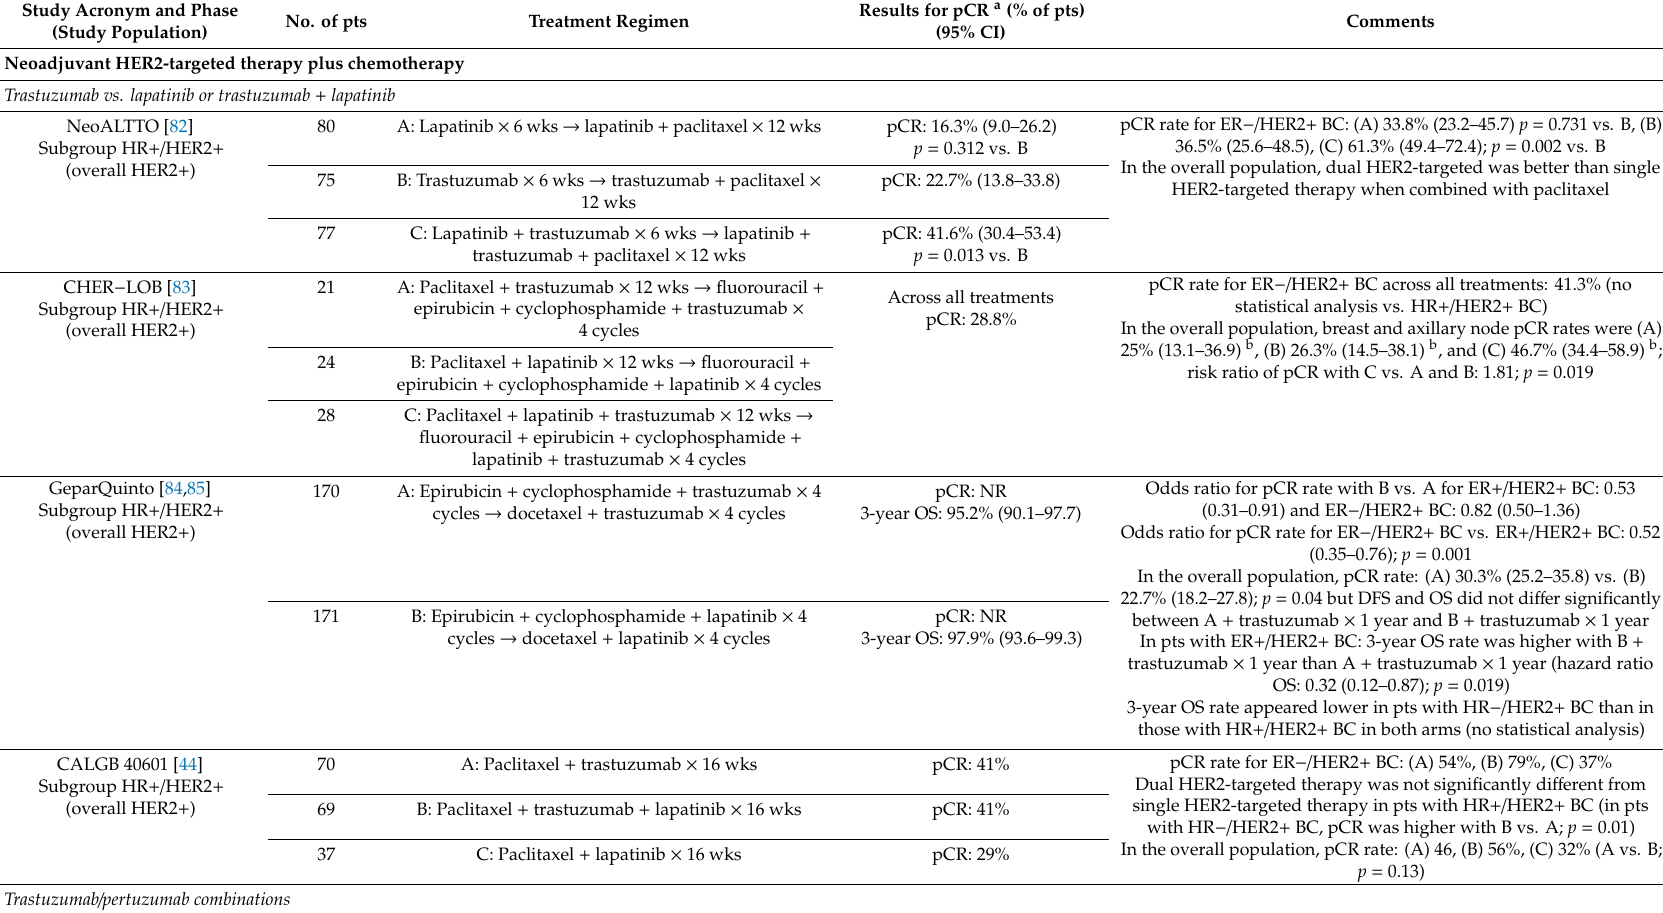
Table 2. Phase II and III trials in the neoadjuvant setting reporting outcomes for patients with HR +/ HER2 + early-stage breast